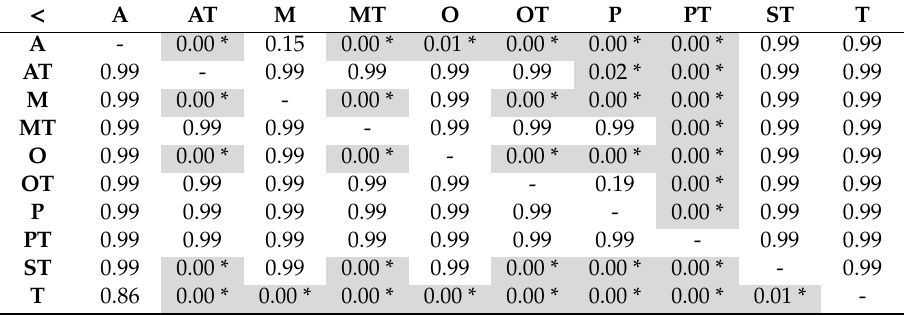
Table 3. One-tailed significance values resulting from pairwise Mann-Whitney U tests (with Bonferroni correction) on the di ff erence between instruction type ratings.